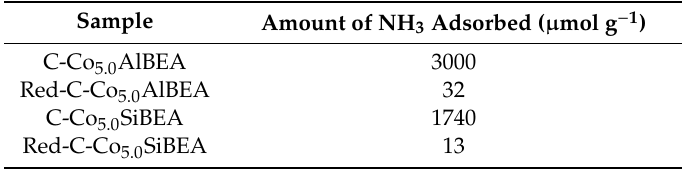
Table 3. The acidity of C-Co 5.0 AlBEA and C-Co 5.0 SiBEA calculated from TPD-NH 3